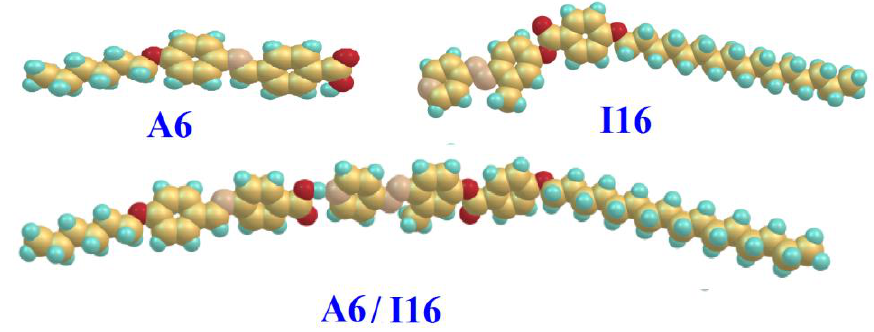
Figure 6. The calculated molecular geometry of the base I16 , the acid A6 and their SMHBCs, A6/I16.